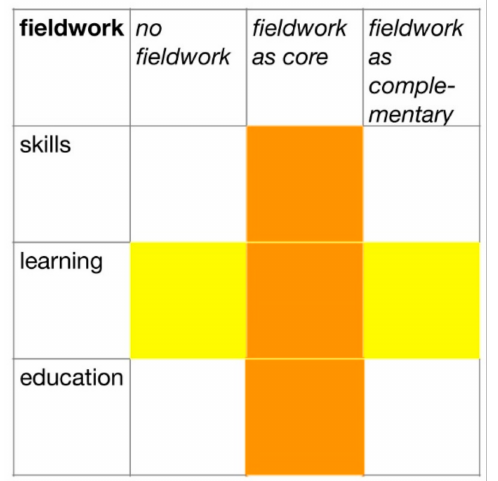
Figure 2. Overview of headlines of pedagogy of fieldwork in landscape architecture. The types of fieldwork are based on a generic distinction in the role of fieldwork in acquiring the body of knowledge from textbooks that are used in landscape architectural education [13–15,64]. The different teaching goals, training skills, acquiring the body of knowledge of a discipline, gaining insight in values as basis for personal development, are distinctions from references on teaching and learning in general